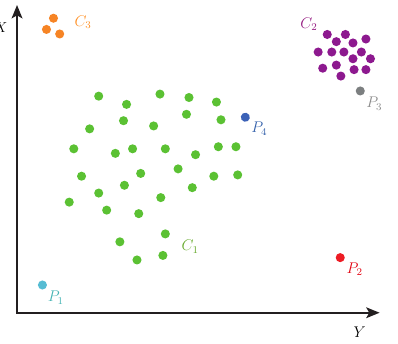
Figure 1: Illustration of the different types of point outliers by means of a two-dimensional synthetic data set. The data set encompasses three clusters C 1 , C 2 , and C 3 of normal data in- stances, two global point outliers P 1 and P 2 , and one local point outlier P 3 . Unlike P 3 , the data instance P 4 is normal and belongs to cluster C 1